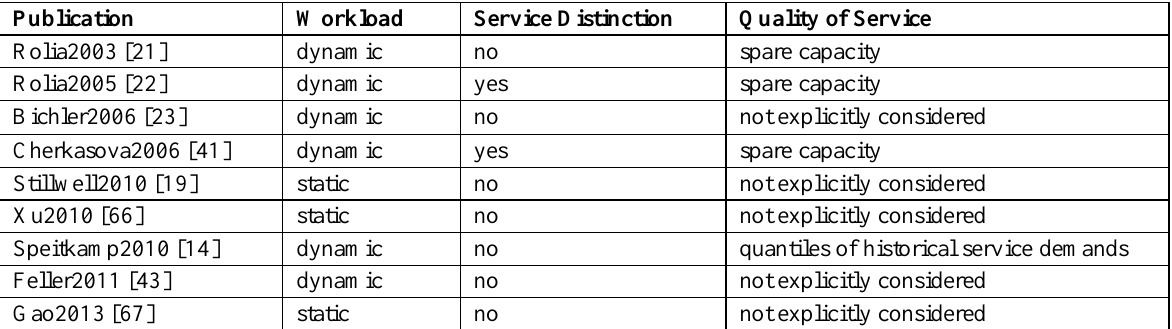
Table 1. Classification of related